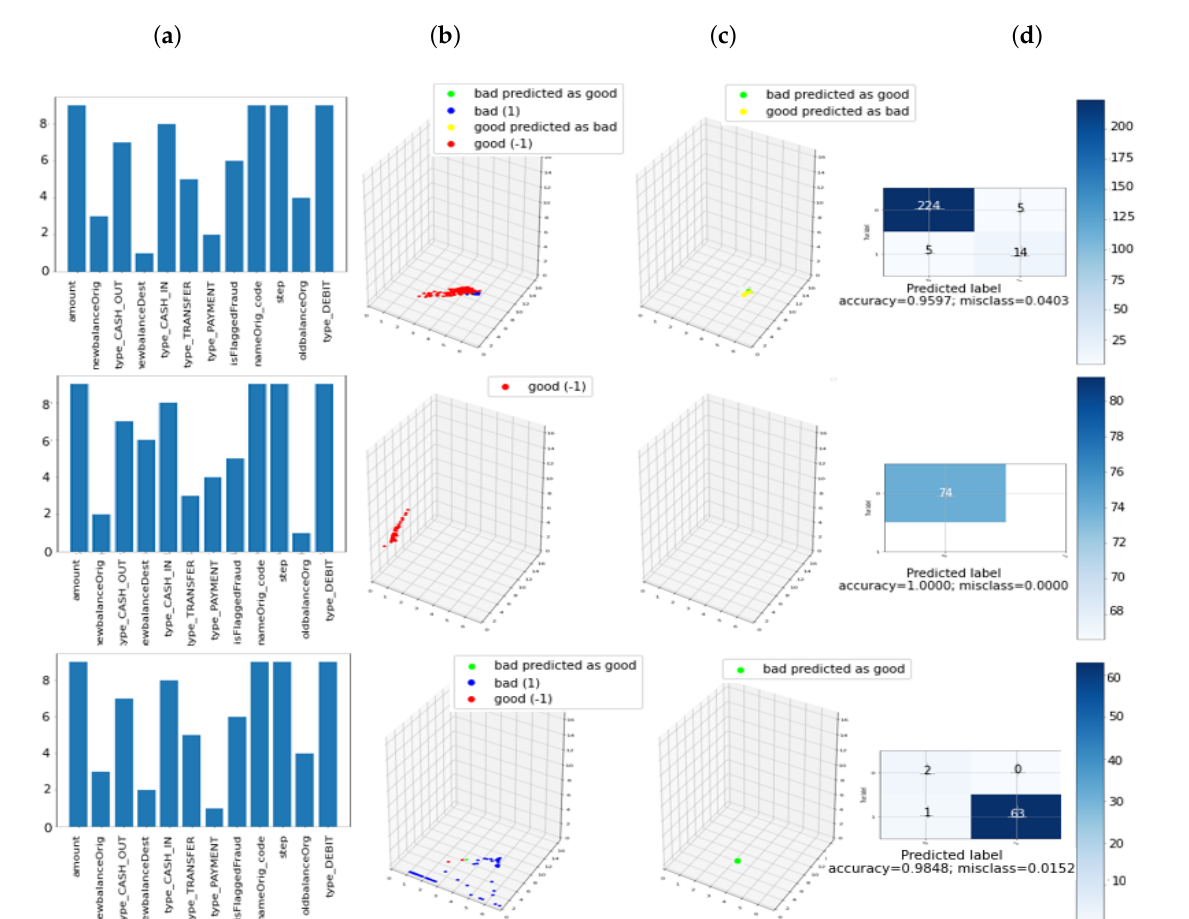
Figure 9. Different groups of ITR in PaySim Dataset. Column ( a ) represents the ITR. In column ( b ) we can see all the transaction with the same ITR with the class predicted with our methodology. Column ( c ) is similar to ( b ) but it only shows the mismatch. Finally, ( d ) shows the confusion matrix for all the transactions with the same